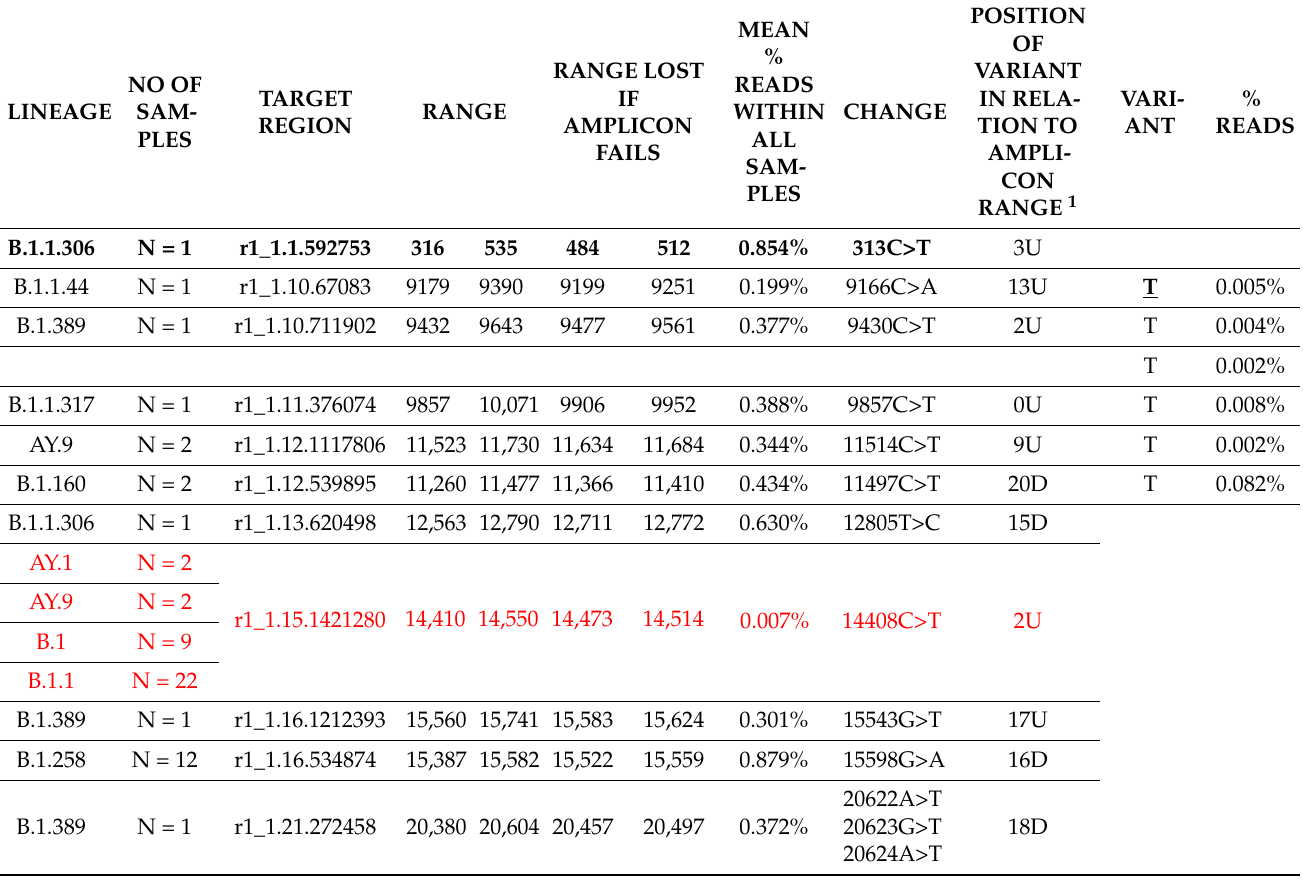
Table 4. Amplicons with low mean percentage of reads within total sample’s reads for specific SARS-CoV-2 lineages and potential SNPs associated with amplification